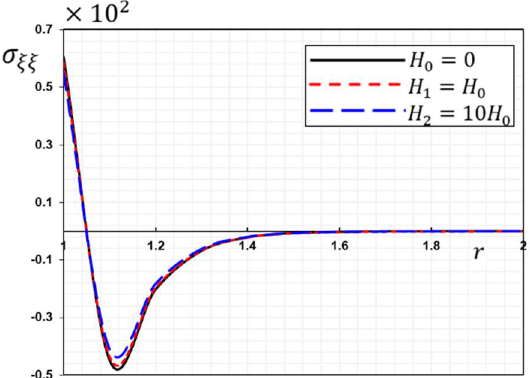
14 of 24 Figure 4. The radial thermal stress, (cid:2026) (cid:3045)(cid:3045) , versus the axial magnetic field, (cid:1834) (cid:2868) . Figure 5 depicts the behavior of hoop stress (cid:2026) (cid:3093)(cid:3093) as the radial distance changes with and without the effect of initial magnetic field (cid:1834) (cid:2868) changing. As the illustration shows, there is circumferential compressive stress for the transversely isotropic material. It is also clear from the figure that the behavior of circumferential stress (cid:2026) (cid:3093)(cid:3093) is the same as that of radial stress (cid:2026) (cid:3045)(cid:3045) , but the difference is in the starting point, where the hoop stress starts